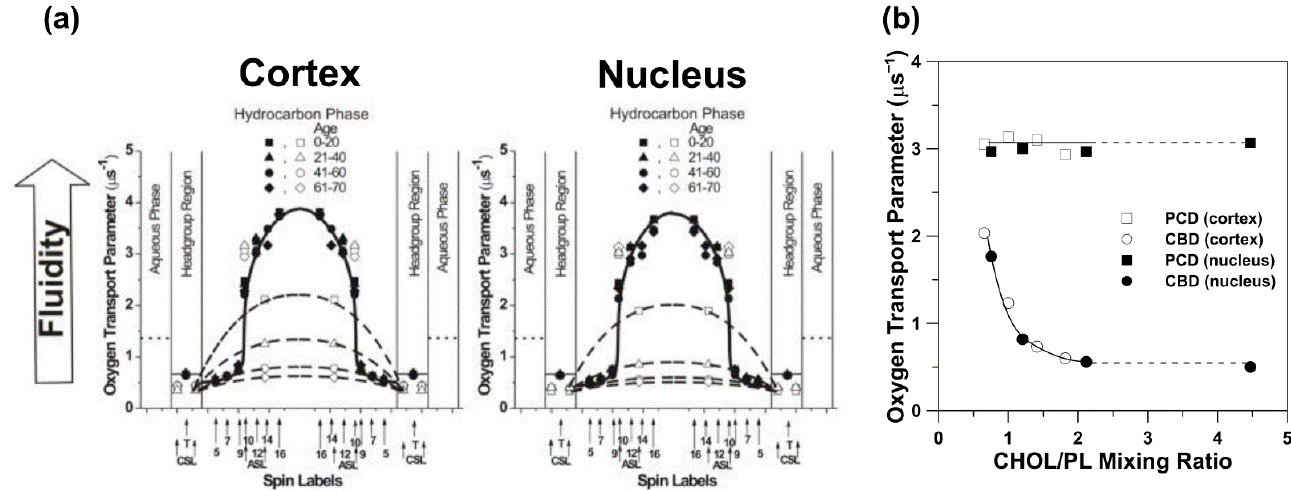
Figure 7. ( a ) Transmembrane profiles of the OTP for LLMs obtained from human donors of different age groups. Profiles were obtained at 37 °C for LLMs prepared using the rapid solvent exchange method [85]. Profiles obtained with the PL-analog spin labels (filled symbols) are not contaminated by the presence of CBDs. Data obtained with Chol-analog spin labels (open symbols) are also included, showing that the CBDs are present in LLMs from all age groups. Thus, the PL bilayers in LLMs are always saturated with Chol. Approximate locations of the nitroxide moieties of spin labels are indicated by arrows. The OTP value in water is shown by dotted lines. ( b ) The OTP obtained with ASL in cortical and nuclear LLM plotted as a function of Chol content in these membranes (expressed as the Chol/PL mixing ratio). At a Chol/PL mixing ratio of ~2, the Chol crystals are formed. Thus, the Chol/PL molar ratio in phospholipid bilayers and the amount of Chol forming CBDs should not increase further. Chol crystals were detected in nuclear LLMs from the age group comprising 61–70 years (with a Chol/PL ratio of 4.4). ( a ) is reproduced from [83]. Copyright 2022, with permission from Taylor and Francis. Data for ( b ) are adapted from